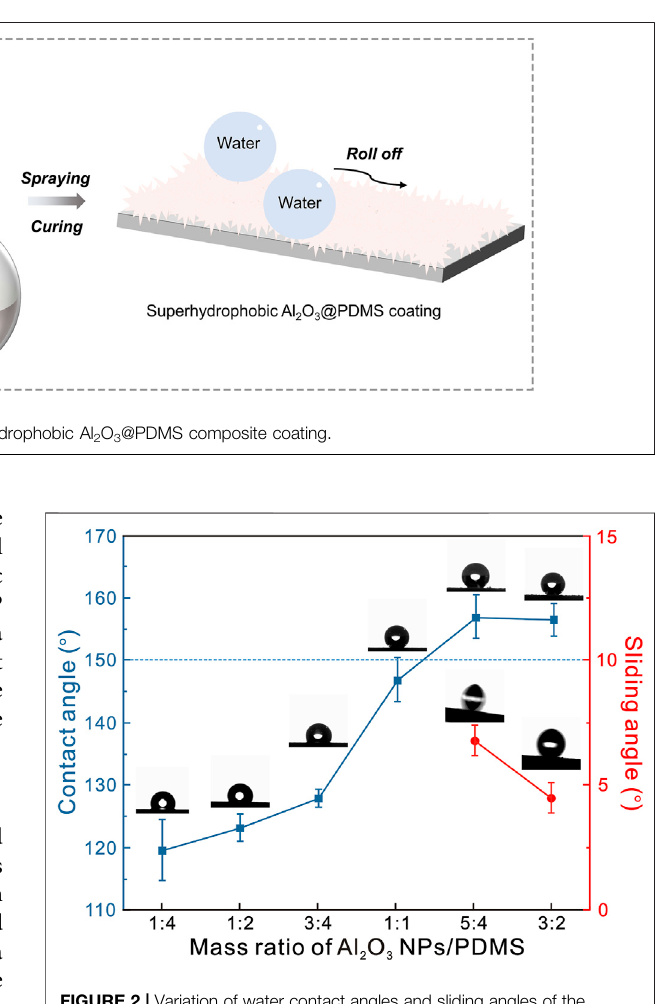
FIGURE 2 | Variation of water contact angles and sliding angles of the